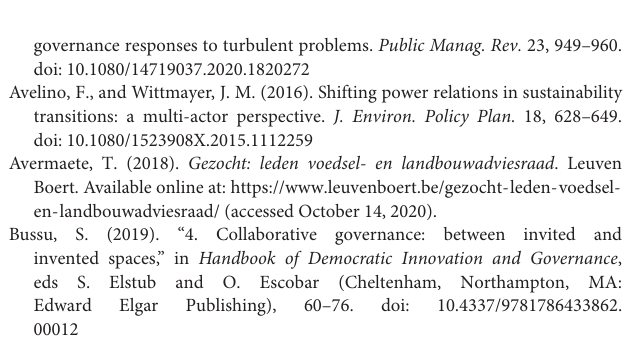
Supplementary Figure 1 | The LeuvenGymkhana 2.0 Timeline. JPGE high-resolution version of the timeline exhibited and explained during the Leuven Gymkhana 2.0 tours. Supplementary Table 1 | Annex 1. List of